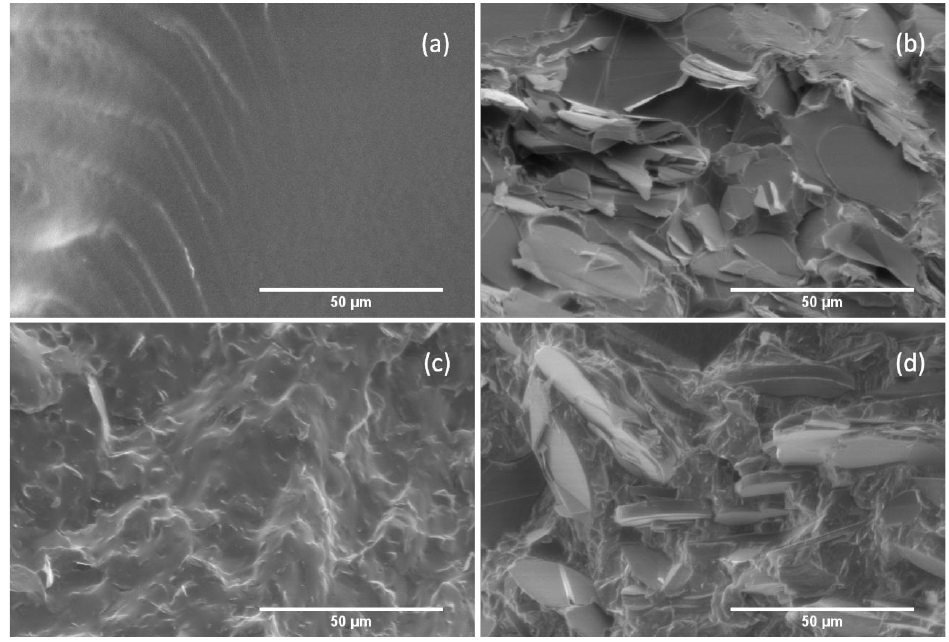
Figure 10. SEM images: ( a ) neat PDMS; ( b ) hBN (50%); ( c ) GNP (8%); and ( d ) hBN (40%)/GNP (10%) samples.